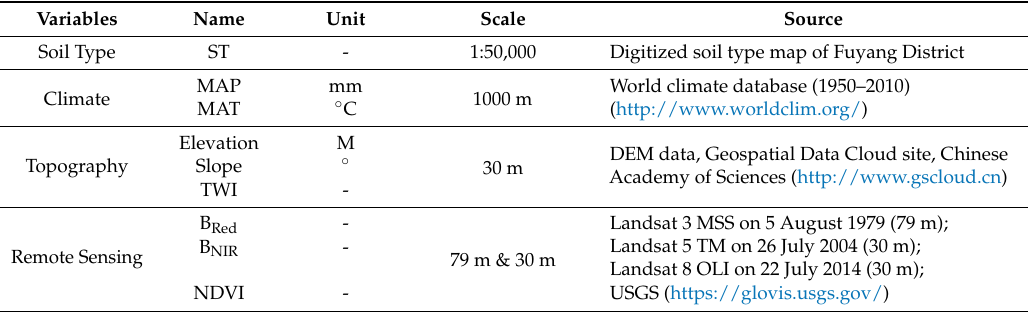
Table 1. Description of the environmental variables utilized for predicting soil